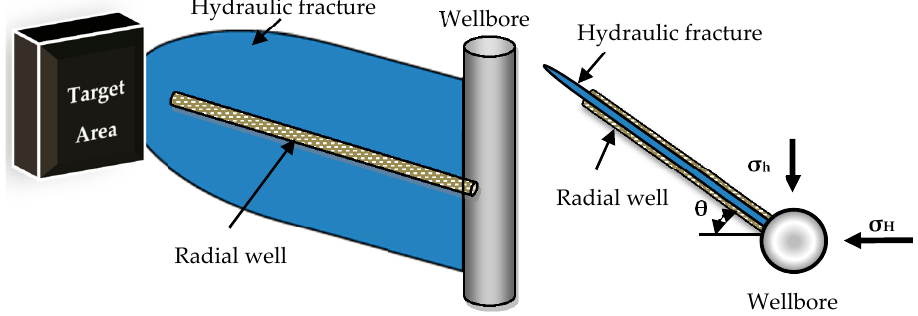
Figure 1. Schematic diagram of hydraulic fracture-directed propagation guided by a single radial well.